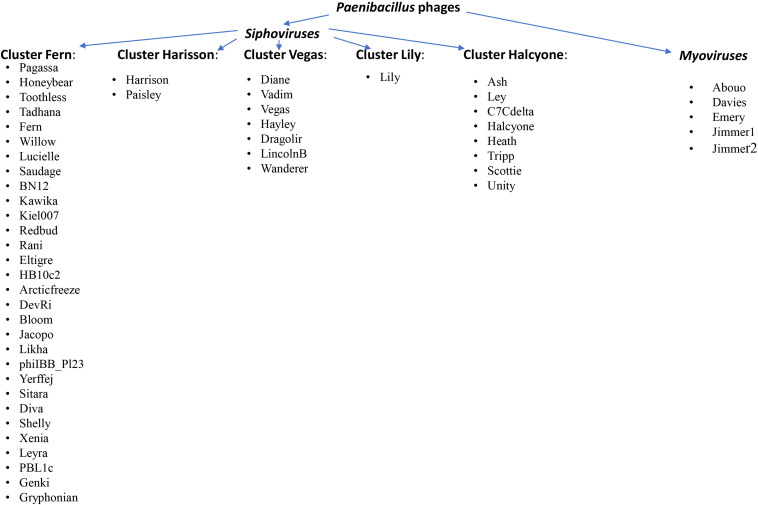
Division of Paenibacillus phages into individual groups, including families to which they belong (Stamereilers et al., 2018; Tsourkas, 2020).